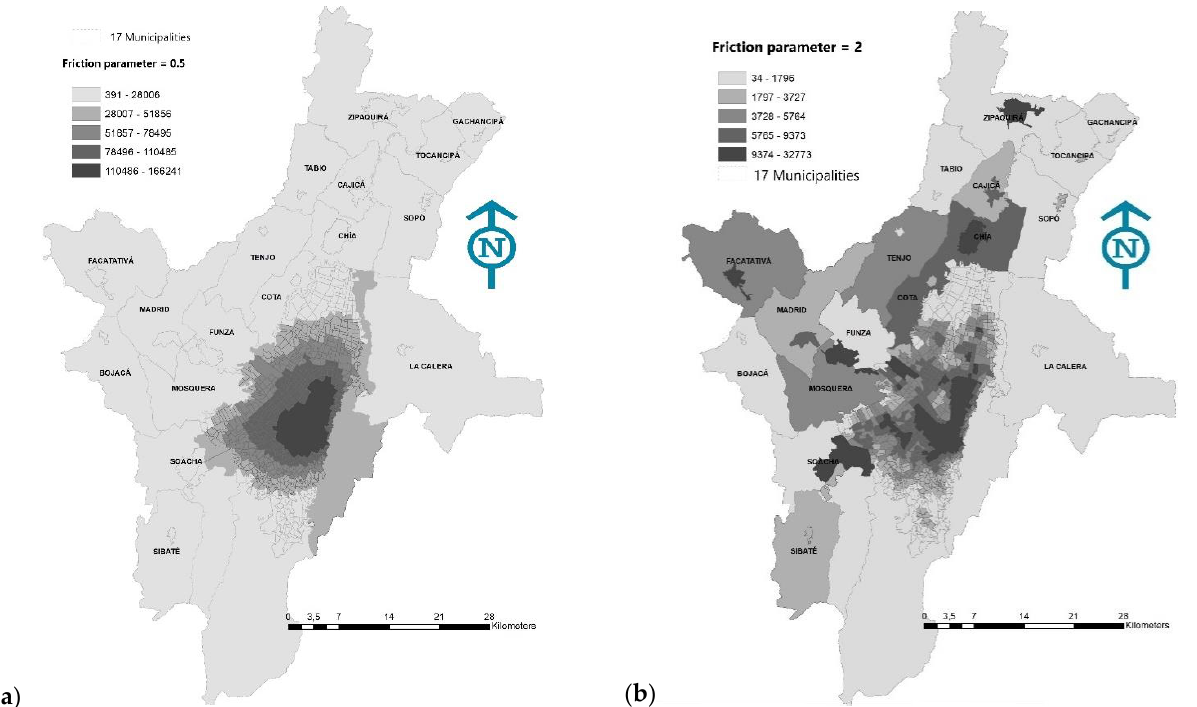
Land 2021 , 10 , x FOR PEER REVIEW 22 of 24 Figure A2. Small – Hsiao test to check independent alternatives. Figure A2. Small–Hsiao test to check independent alternatives.